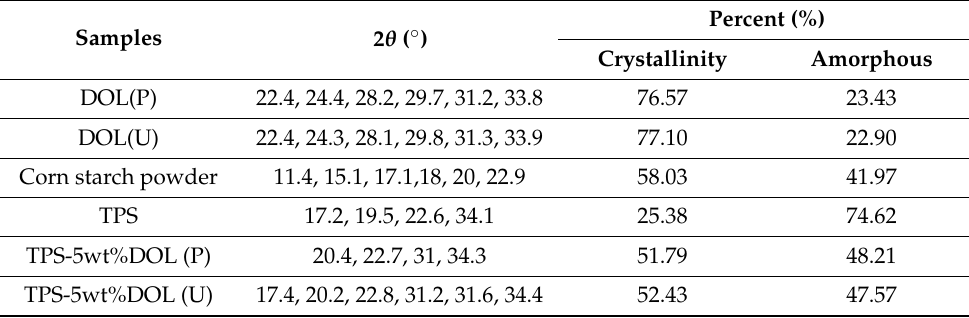
Table 3. Crystallinity of the pristine dolomite (DOL(P)), sonicated dolomite (DOL(U)), corn